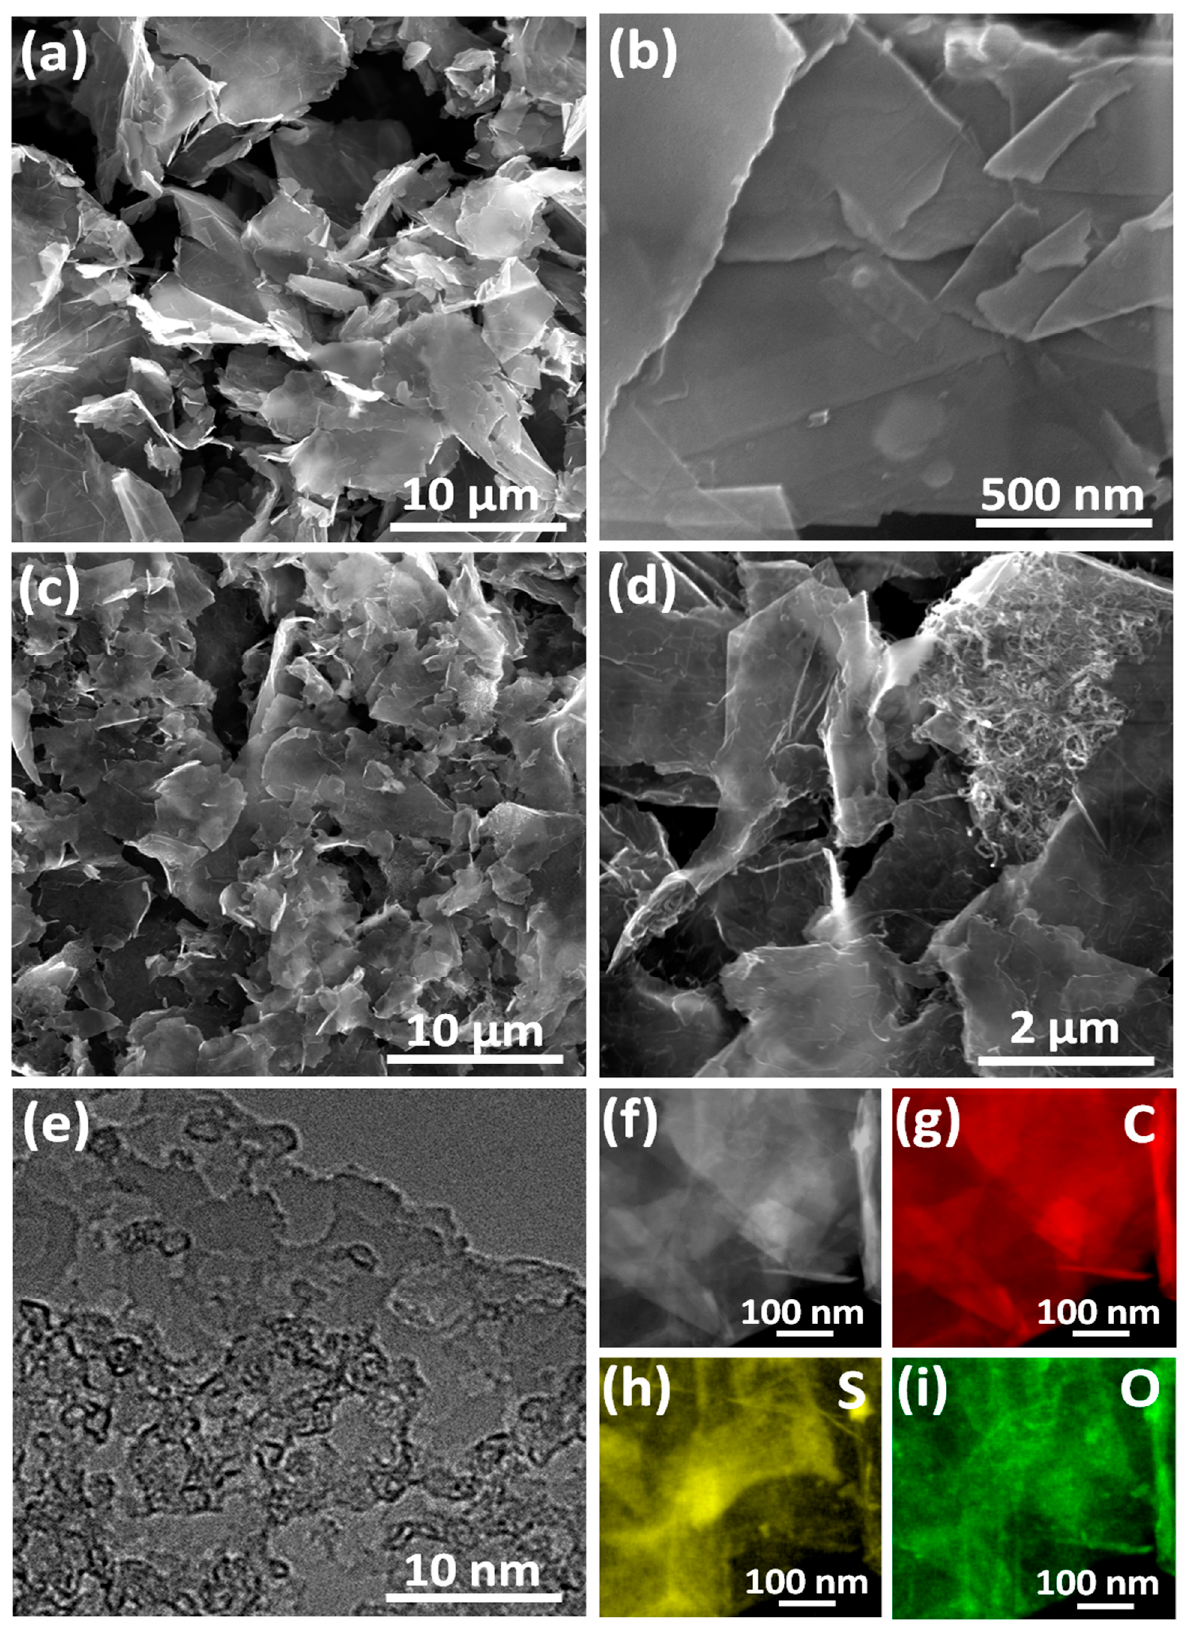
Figure 2. SEM images of ( a , b ) GNS58 powder and ( c , d ) GNS58-CNT10 hybrid cathode at various magnifications ( e ) TEM image of GNS58 powder. ( f ) HAADF image, and ( g – i ) corresponding EDX elemental mapping of GNS58 powder.